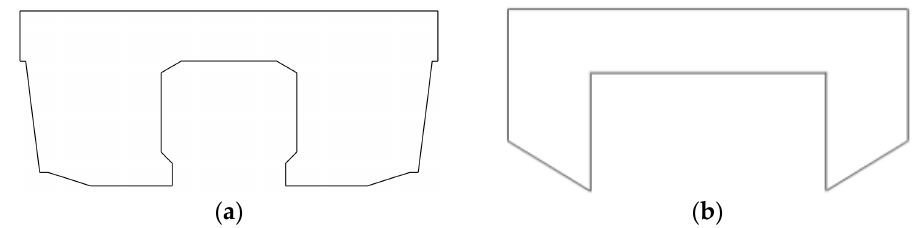
Figure 1. Cross sections of ( a ) partial air cushion support catamaran ( PACSCAT ) and ( b ) a sidewall hovercraft.